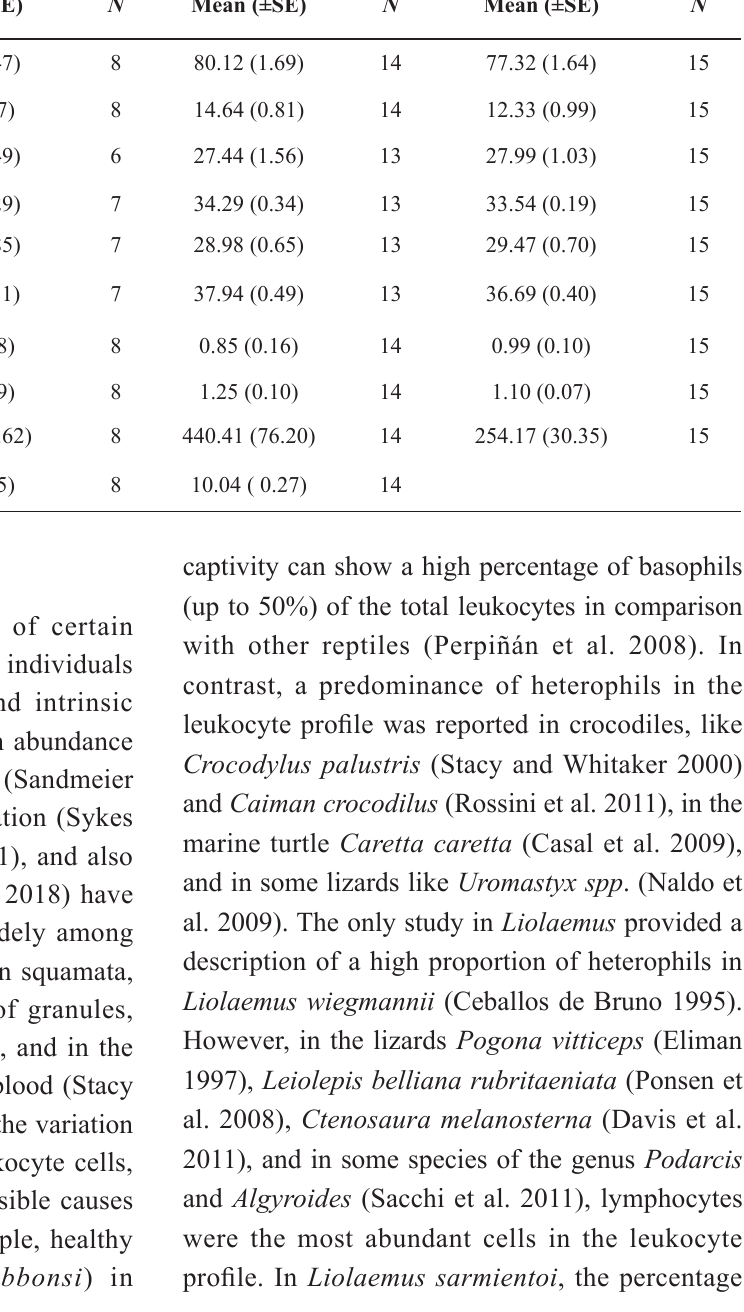
, b ; °C), maximum preferred pref-min